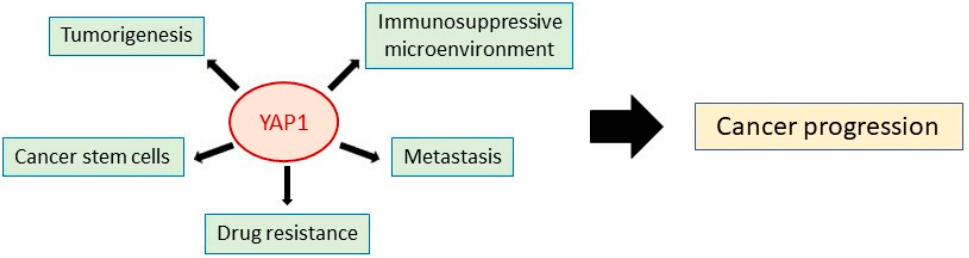
Figure2. Tumor-promotingrolesofYAP1. Figure 2. Tumor-promoting roles of YAP1. YAP1 contributes to cancer progression from multiple aspects, such as tumorigenesis, metastasis, malignant stemness, and immunosuppressive microenvironment.